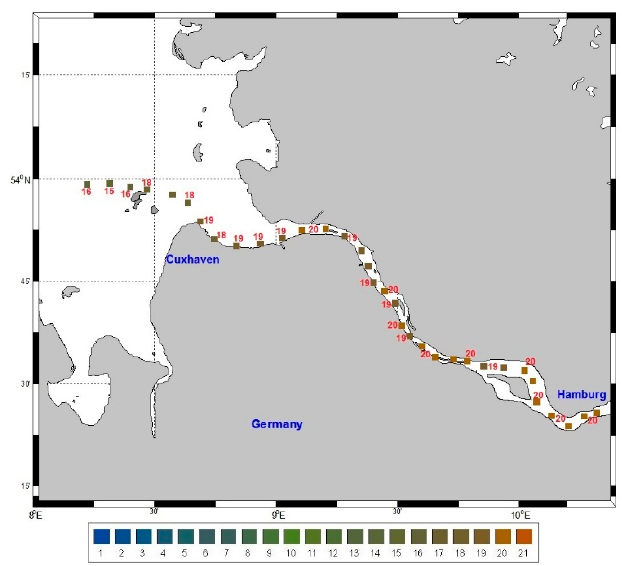
Figure 4. FUI colours of water derived from remote sensing reflectance measured in the Elbe estuarine system in May 2013. The FUI colours were validated and corrected using field observations with a handheld FUI colour scale.